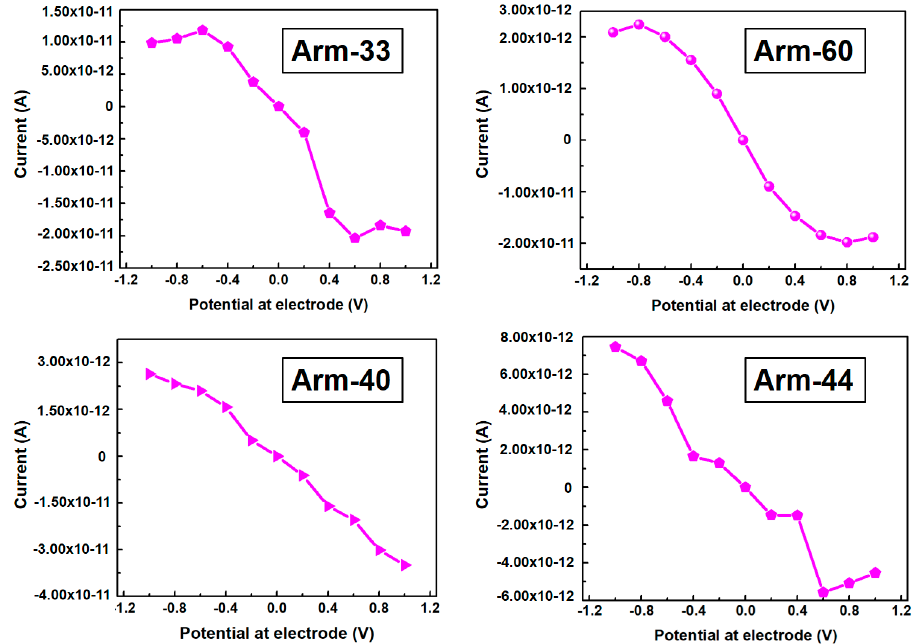
Figure 5. The curve of voltage and current (U/I) of arm-33, arm-60, arm-40, and arm-44 respectively.